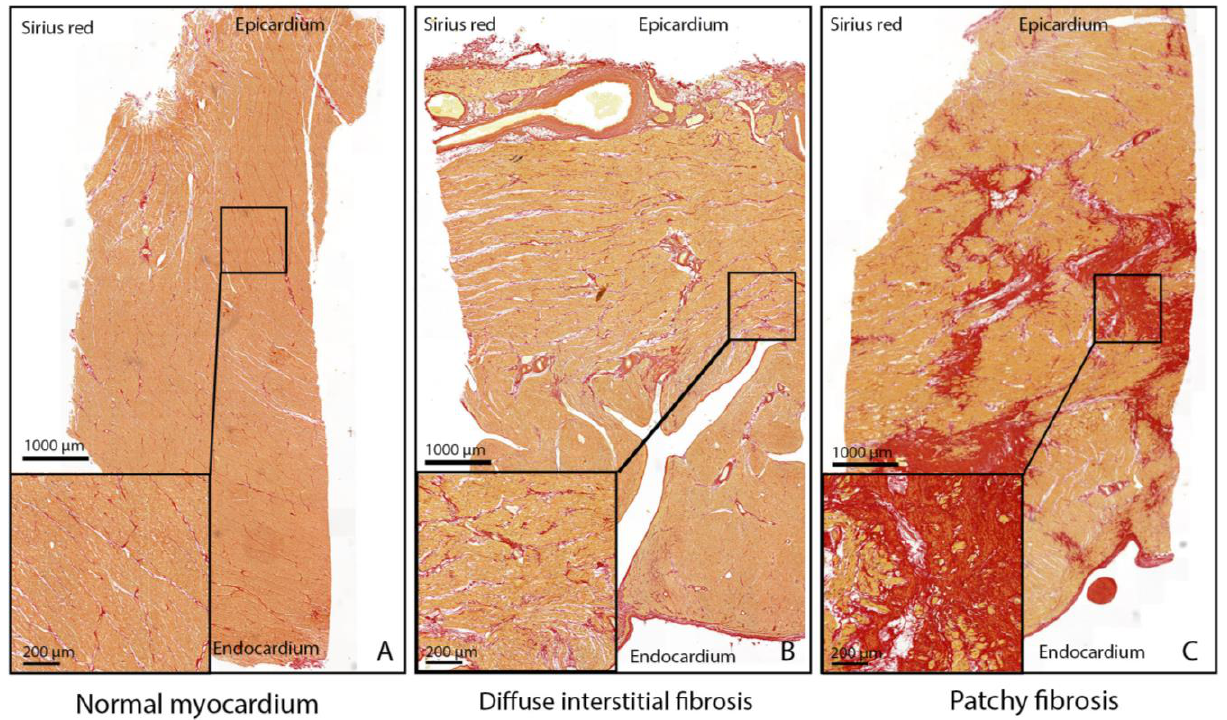
Figure 3. Myocardial fibrosis patterns in control and transposition of the great arteries. Myocardial fibrosis patterns using Sirius red staining. ( A ) Myocardium with normal pattern and amount of collagen. ( B ) Diffuse distribution of interstitial myocardial fibrosis. ( C ) Multiple areas with patchy fibrosis.